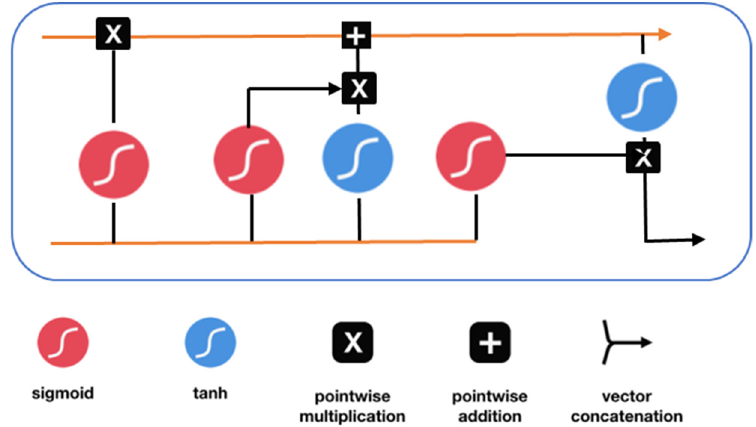
Figure 4. LSTM internal structure.